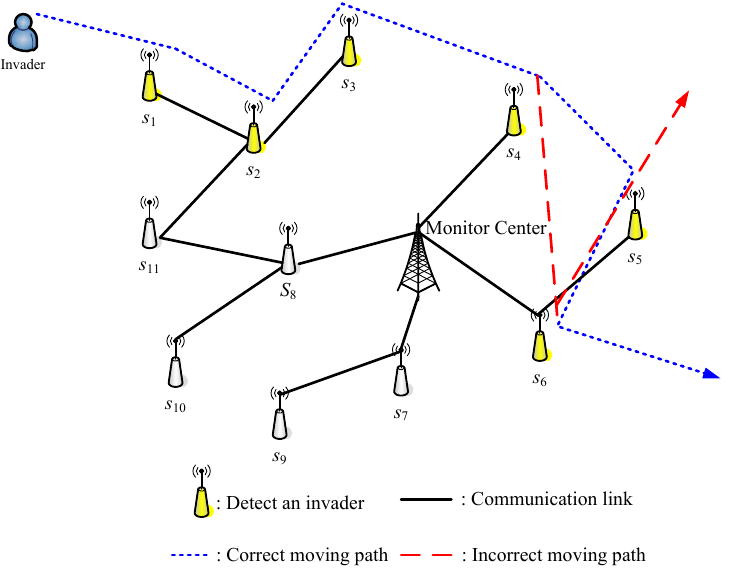
Figure 1. Temporal events ordering